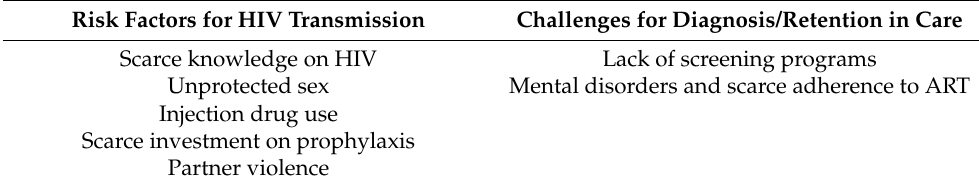
Table 1. Risk factors for HIV transmission and challenges for diagnosis and retention in